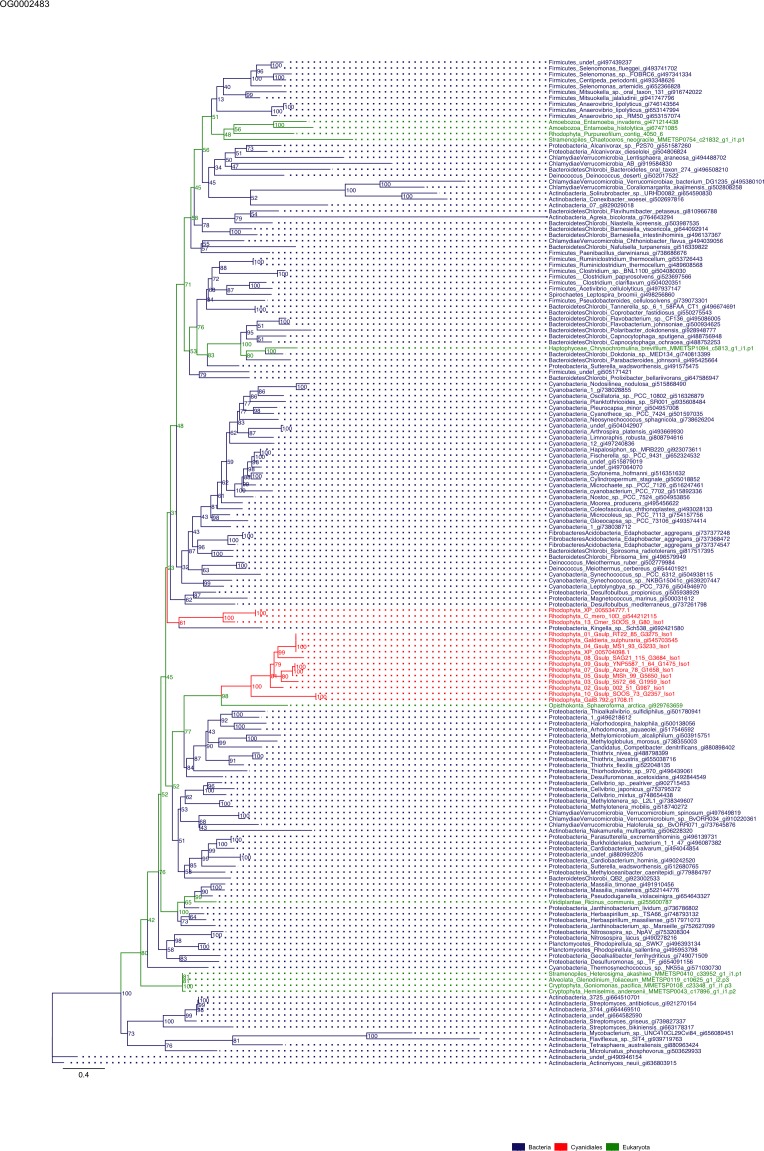
Sequence tree of orthogroup OG0002483.The tree is based on amino acid sequences. Archaea (yellow), Bacteria (blue), Cyanidiales (red), Eukaryotes including other red algae (green). Branches containing Cyanidiales sequences are highlited in red.